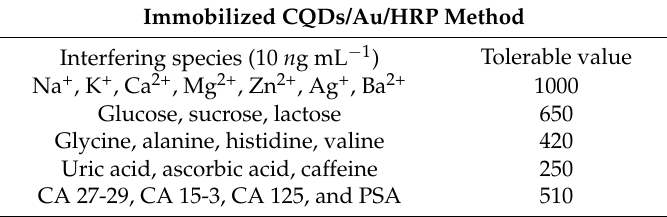
Table 3. Tolerance limits of interferences in the detection of CA 19-9 antigen in serum using fluorescence CQDs/Au–Ab–HRP immunoassay